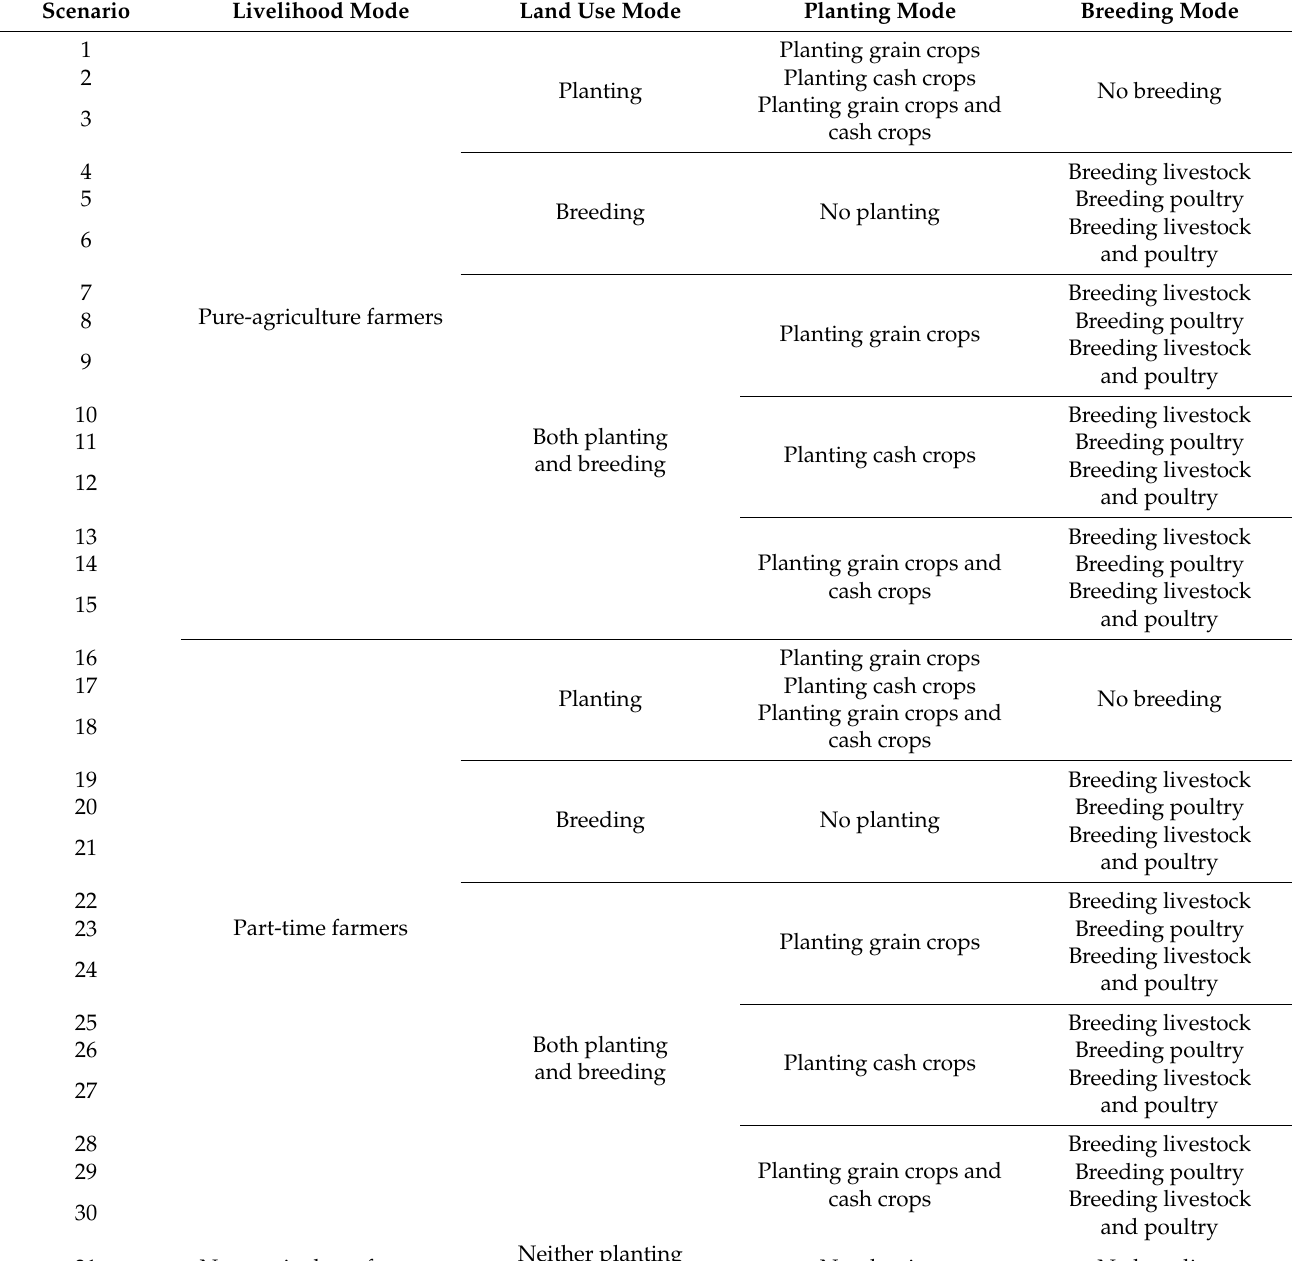
Table 5. Scenario setting under different strategy